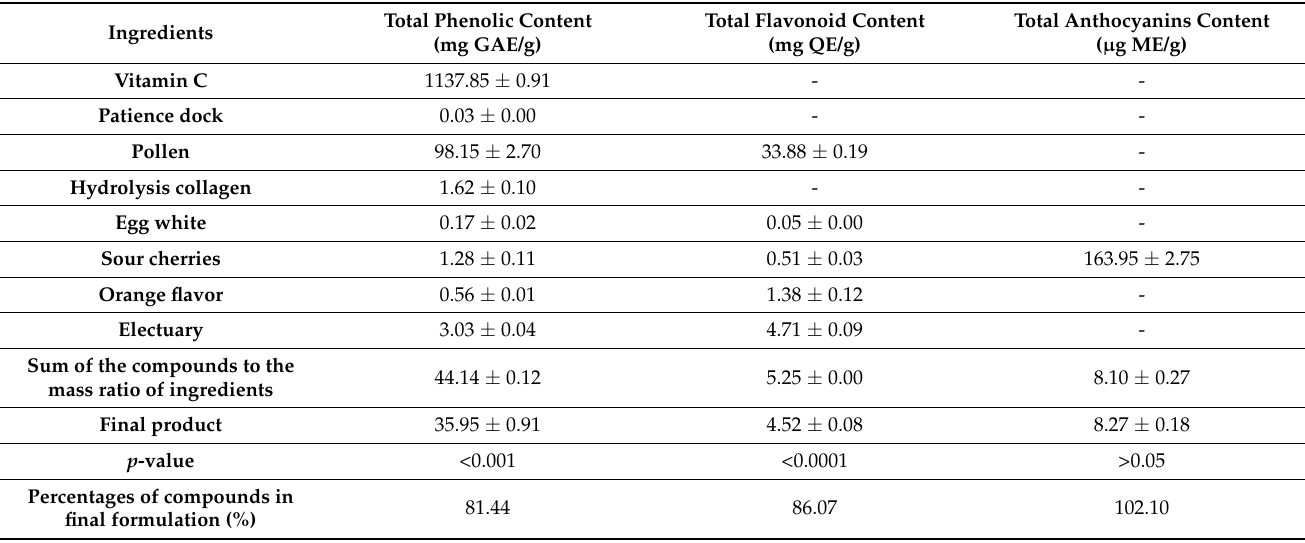
Table 3. Chemical content of phenolics, flavonoids, and anthocyanins for ingredients and final product.